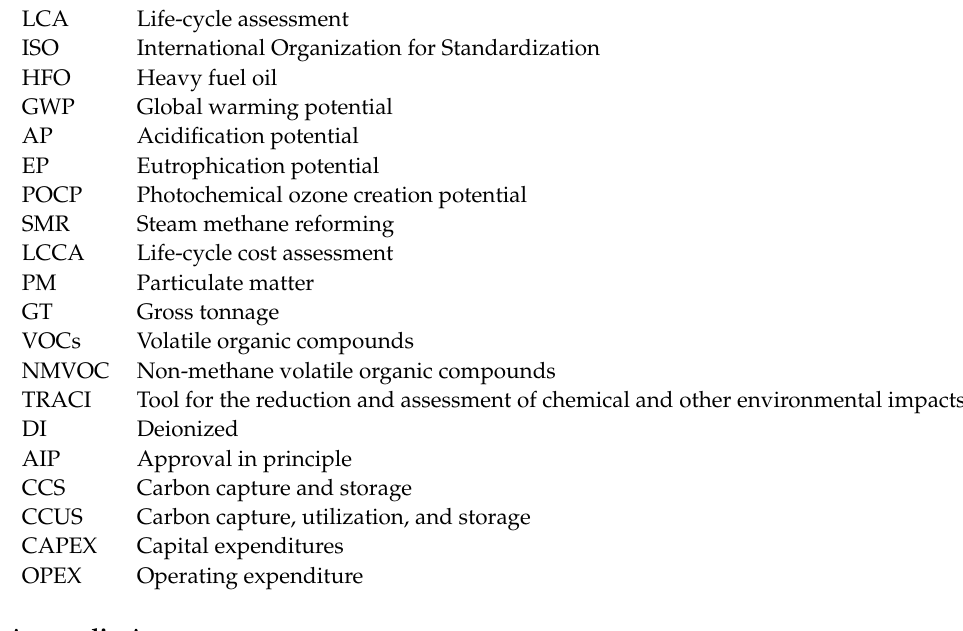
Table A1. Results of the environmental impact assessment in the well-to-tank phase. MGO LNG Hydrogen GWP (kg CO 2 equiv.) 4,250,620.10 4,033,280.24 33,706,772.69 AP (kg SO 2 equiv.) 13,283.88 6245.23 17,693.00 EP (kg N equiv.) 2687.37 2579.93 8691.01 POCP (kg NMVOC equiv.) 12,122.20 9712.52 PM (kg PM 2.5 equiv.) Table A2. Results of the environmental impact assessment in the tank-to-wake phase. MGO LNG Hydrogen GWP (kg CO 2 equiv.) 26,280,812.67 26,156,802.07 0 AP (kg SO 2 equiv.) 239,341.28 29,206.76 0 EP (kg N equiv.) 36,816.46 22,517.70 0 POCP (kg NMVOC equiv.) 131,671.37 85,280.95 0 PM (kg PM 2.5 equiv.) 16,100.50 Table A3. Results of the environmental impact assessment in the well-to-wake phase. MGO LNG Hydrogen GWP (kg CO 2 equiv.) 30,531,432.37 30,190,082.31 33,706,772.69 AP (kg SO 2 equiv.) 251,955.04 35,451.98 17,693.00 EP (kg N equiv.) 39,057.29 25,097.62 8691.01 POCP (kg NMVOC equiv.) 143,152.76 94,993.46 26,980.69 PM (kg PM 2.5 equiv.) 18,249.31